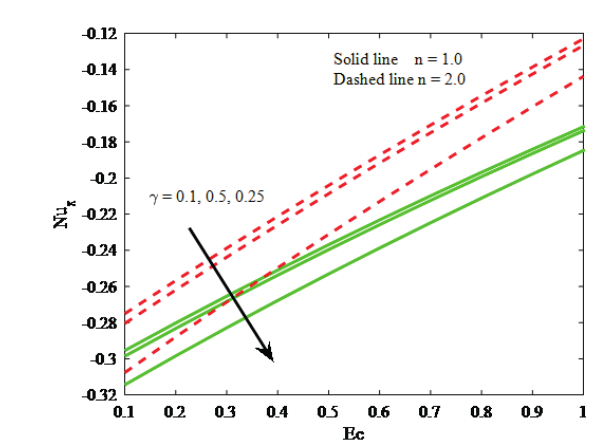
Fig. 15: Impact of Bi on temperature.